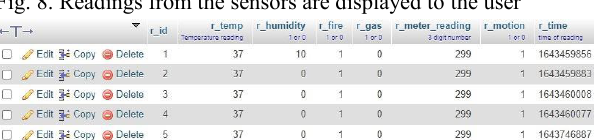
Fig. 8. Readings from the sensors are displayed to the user